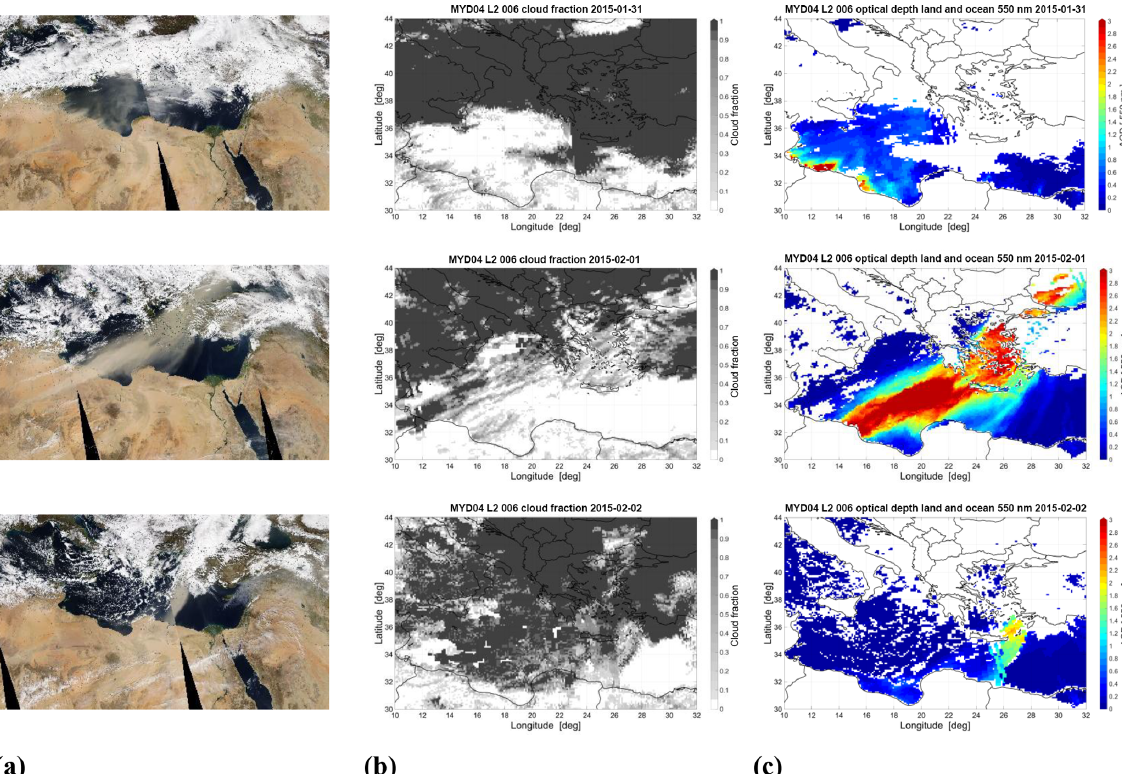
Figure 2. Satellite observation of the temporal evolution of the dust incursion peaking on 1 February 2015 over Greece from MODIS/Aqua satellite data. (a) True colour imagery based on bands 1, 3 and 4. (b) Evolution of the cloud fraction and (c) AOD on the day before (top), during (centre) and after (bottom) peak dust. Note that the days on either side of the peak are extensively cloud covered. High values of AOD were observed up to 3 days before and after the peak.